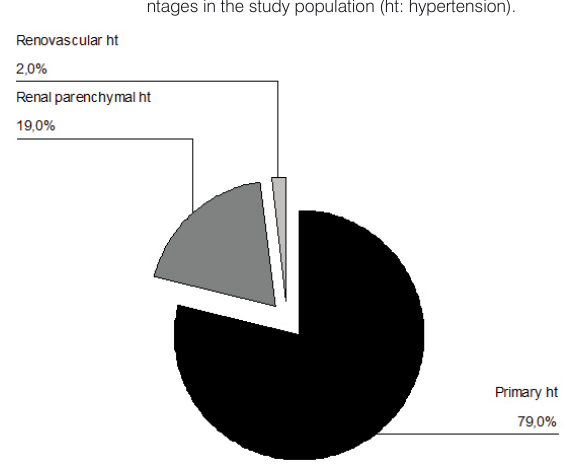
Figure 1. Final diagnosis of etiology of hypertension and perce- ntages in the study population (ht: